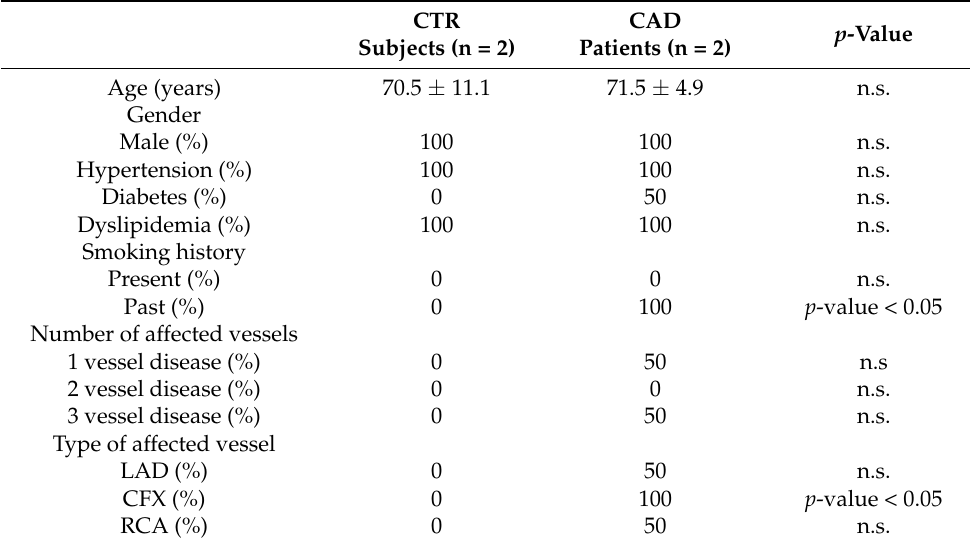
Table 2. Clinical features of CTR subjects and CAD patients (n = 2) selected for miRNA-sequencing and genome-wide methylation